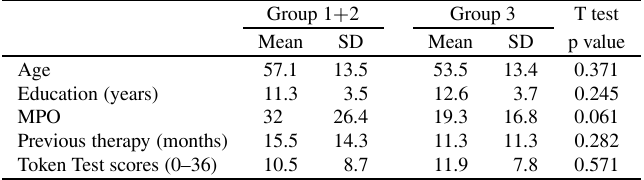
Table 3 Comparison of demographic data and Token Test scores of Groups 1 + 2 ( n = 21) and Group 3 ( n =